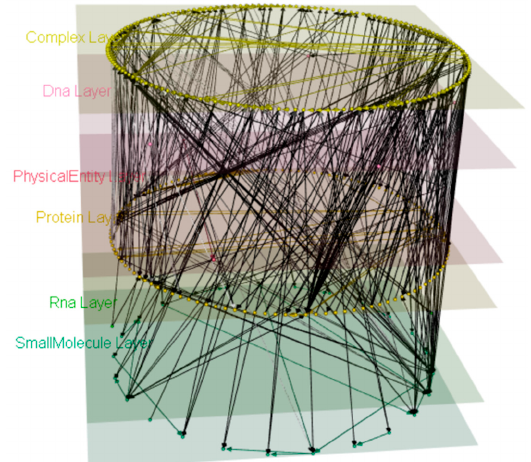
Figure 4. Signaling by Wnt mully model. The model was built using the BioPAX level 3 Signaling by Wnt from Reactome. The model has 6 layers, 311 nodes, and 539 edges.